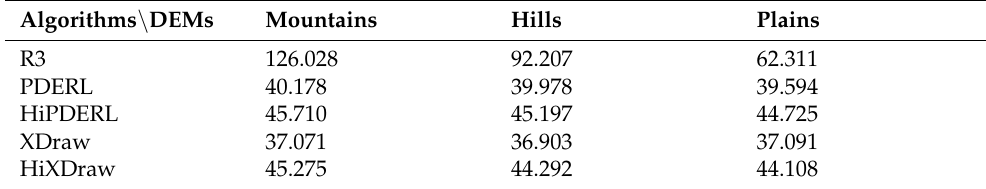
Table 4. Time consumed on different DEMs with different algorithms